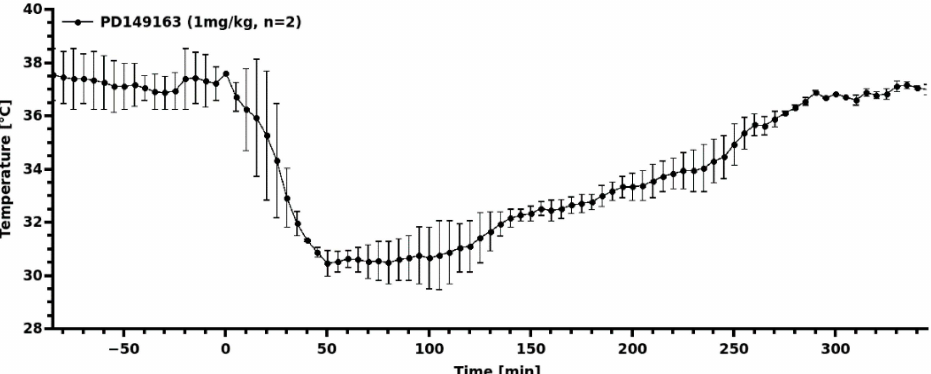
Figure A3. Development of hypothermia after tail vein administration of PD149163. Mice (n = 2) were injected at time 0 via the tail vein with 1 mg/kg PD149163, and the temperature recorded with an intraperitoneally-implanted probe as described in the Materials and Methods